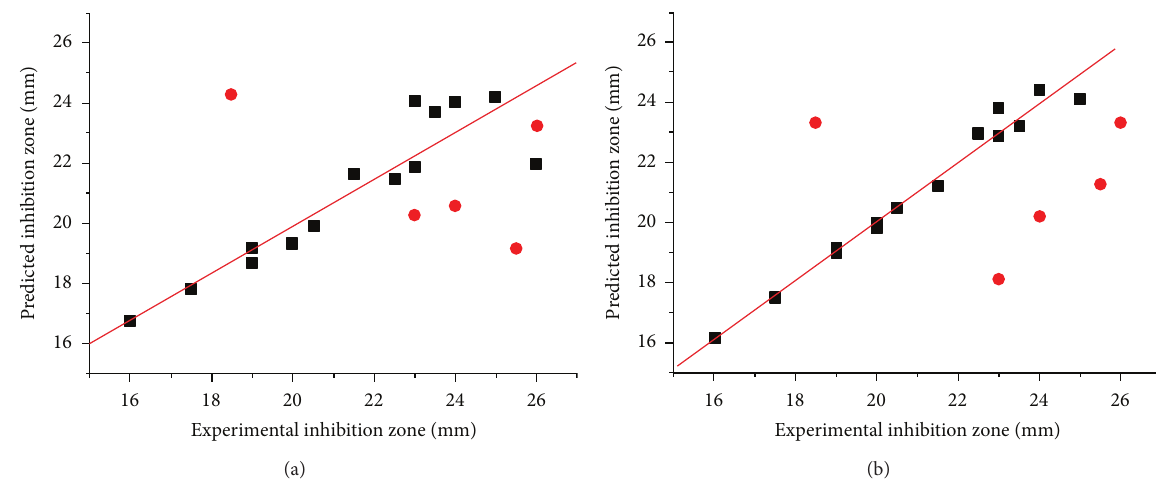
Figure 6: Plots between the experimental and predicted biological activities of training (filled square) and test set (filled circle): (a) CoMFA plot and (b) CoMSIA